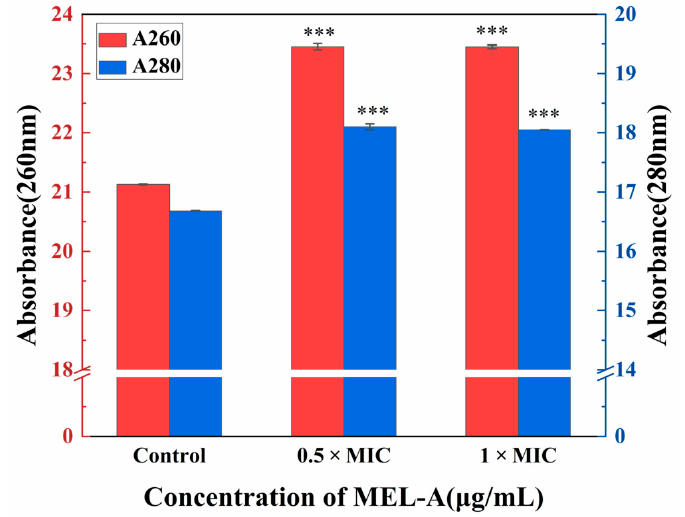
Figure 2. Leakage of the intracellular nucleic acids and proteins. *** (three asterisks) represents significant differences ( p < 0.001) compared to controls. All experiments were performed with three biological replicates ( n = 3).